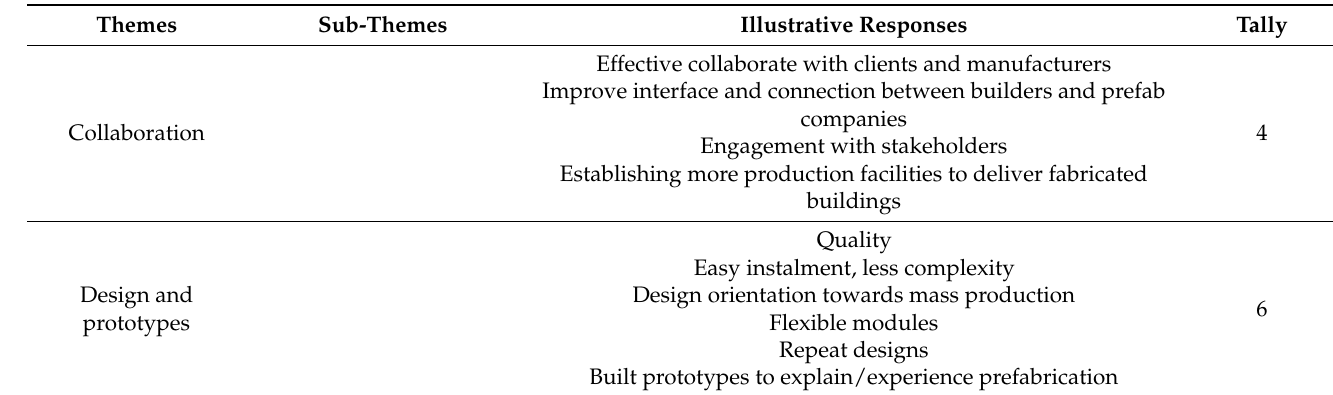
Table 6. Essential measures to increase